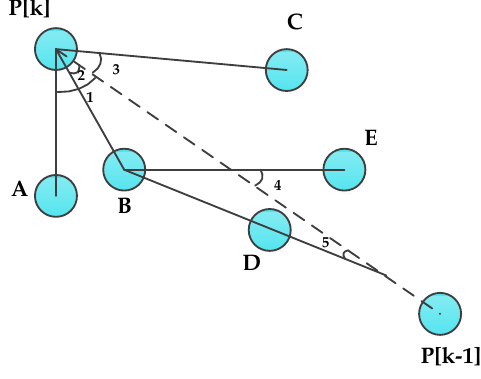
Figure 8. Route deviation angles.